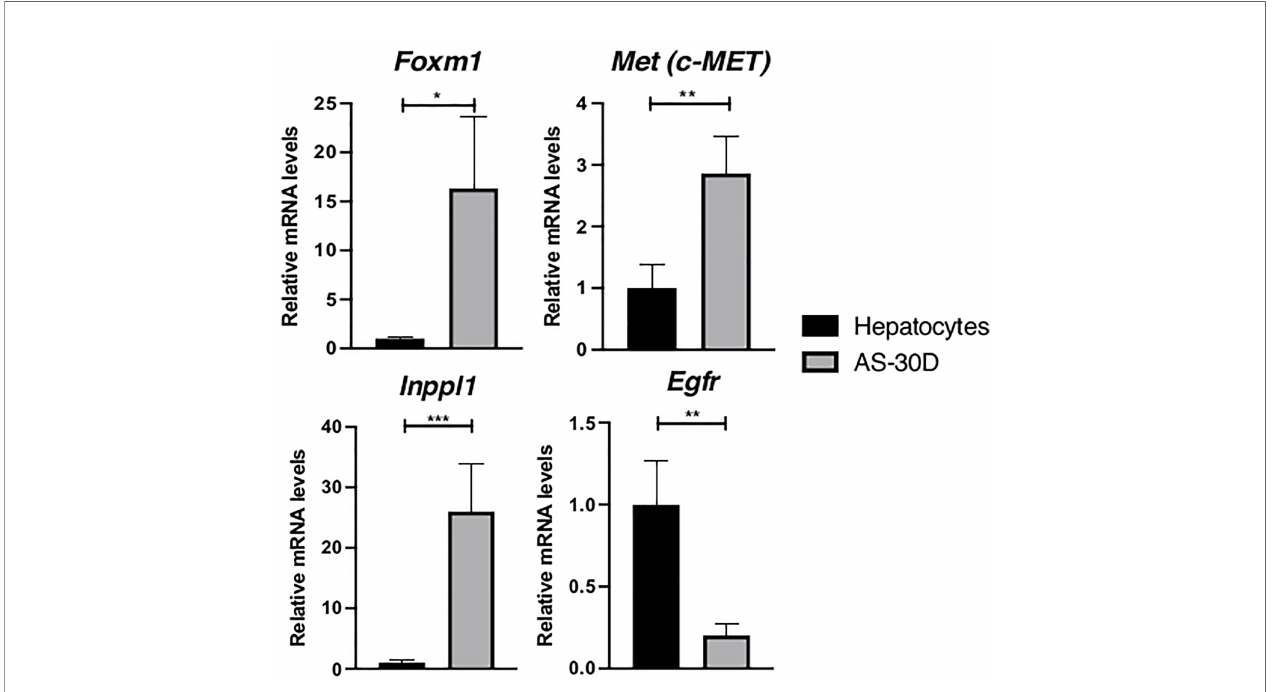
FIGURE 3 | Expression of several genes relatedto metabolic processes or regulation of cell cycle in rat hepatocytes and AS-30Dcells. Rat hepatocytes were freshly isolated, and AS-30D samples were obtained from cells isolated the ascitic fl uid of experimentalrats. Data represented as mean ± SD. *p-values ≤ 0.05; **p ≤ 0.01; ***p ≤